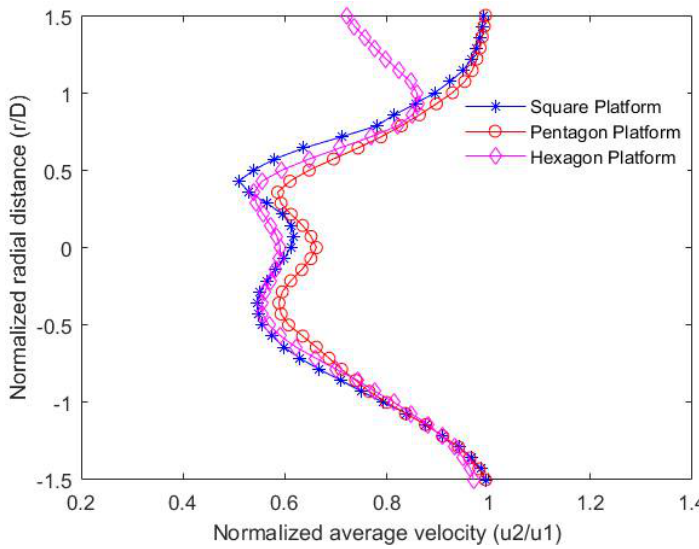
Figure 13. Normalized velocity profile of the downstream turbine.